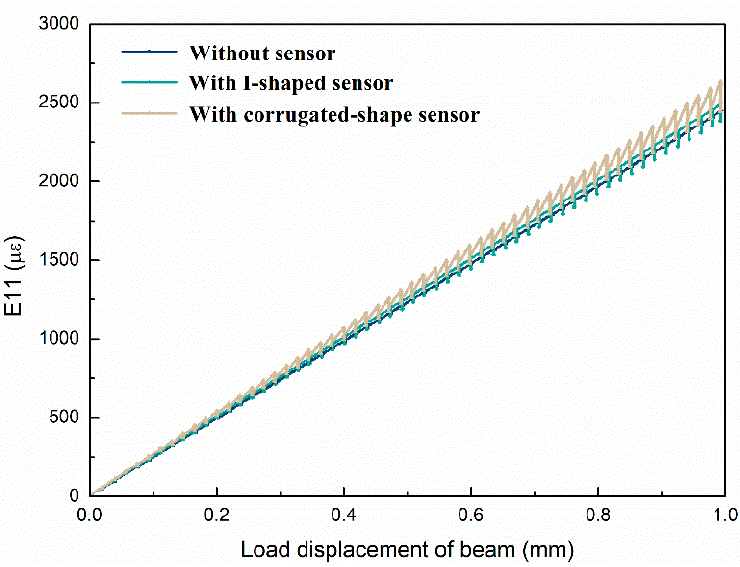
Figure 6. E11 comparison at 90 cm under the three coupling models.